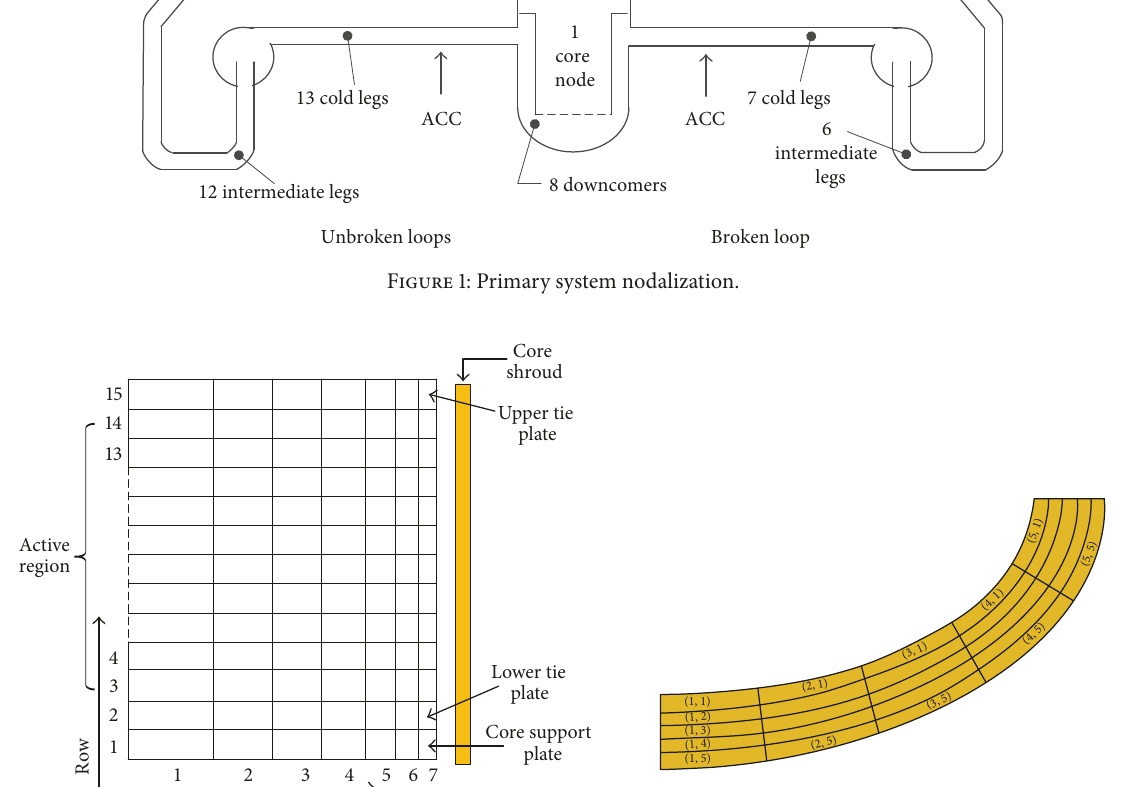
Figure 2: Nodalization of the core and lower